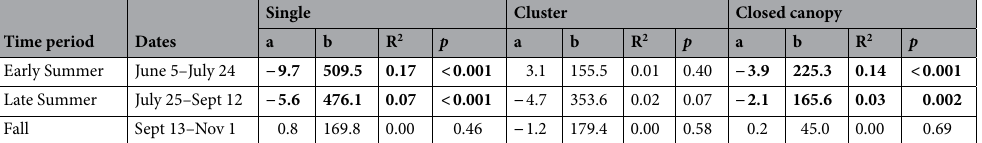
Table 3. Regression parameters and R 2 of daily sum of sap flux density ( J S ) vs. daily average soil moisture content relationships of the form y = a * (soil moisture) + b. Significant relationships are indicated in bold